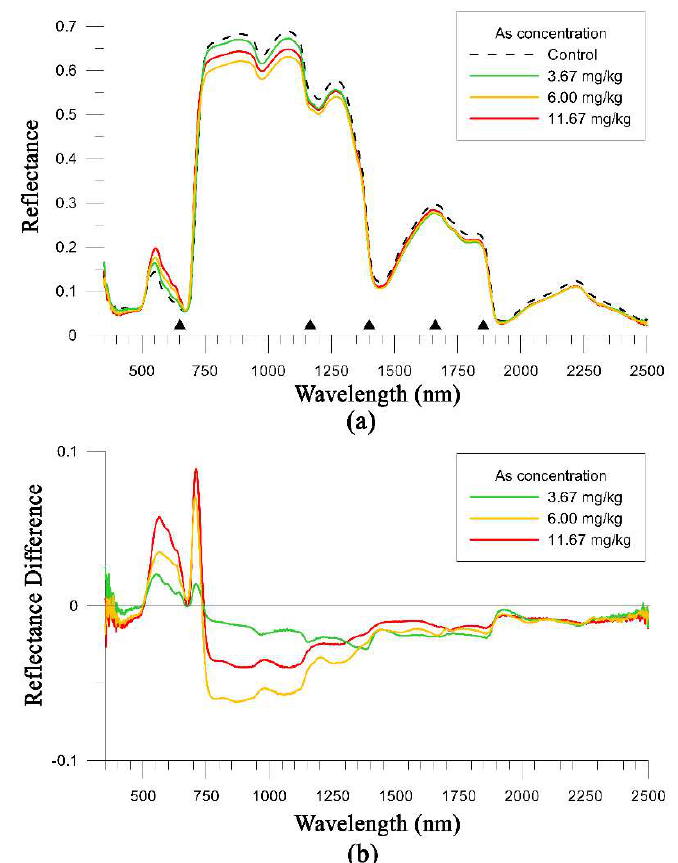
Figure 3. ( a ) The reflectance spectra for control and As-contaminated pine needles at three different levels of content, and ( b ) its RDc. Black triangles indicate wavelength at which the reflectance between control and As-contaminated spectra is statistically different at a significant level of 0.05.